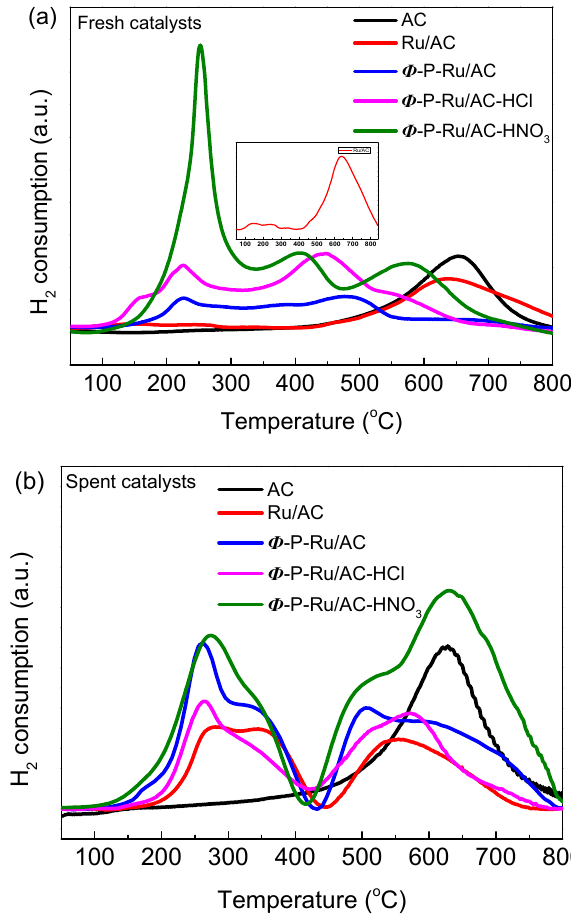
Figure 5. TPR profiles of the fresh ( a ) and spent ( b ) Ru-based catalysts.